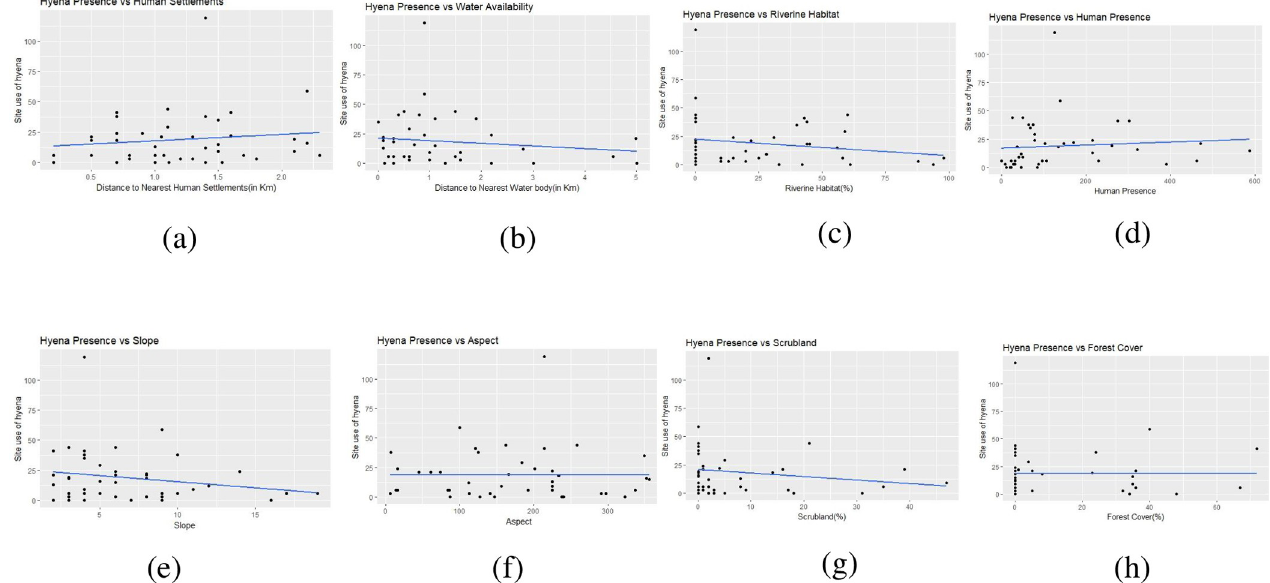
Fig 5. The spatial relationship between the striped hyena and environmental variables (a) hyena vs distance to human settlements or village (km), (b) hyena vs scrubland, (c) hyena vs distance to water (km), (d) hyena vs aspect, (e) hyena vs slope (f) hyena vs riverine area, (g) hyena vs forest cover (h) hyena vs human presence, in the human-dominated landscape of Sawai Mansingh wildlife sanctuary,